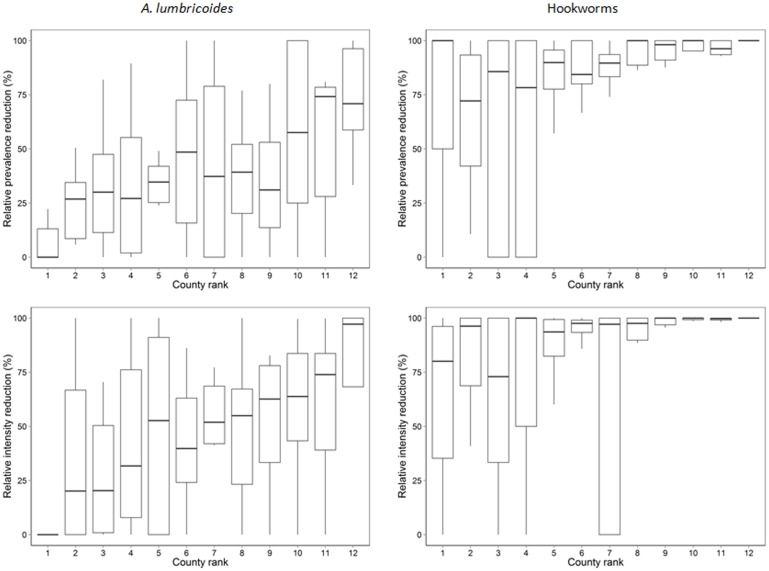
School heterogeneity in relative infection reductions within counties.Counties were ranked lowest to highest according to the relative reduction in prevalence and average intensity of infection. For hookworm, 13 schools with zero infections in both the baseline and follow-up surveys were excluded from the box-plot; schools with increase in infection are plotted as zero relative reduction.